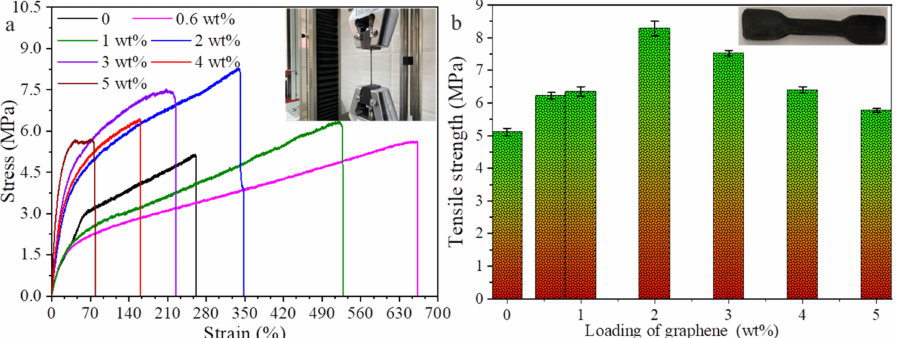
Figure 7. Stress–strain ( a ) and tensile strength ( b ) of G-TPU films prepared with 20 wt% TPU and different loadings of graphene. The inserts are the photographs of the tested samples. Error bars in the plots are standard error.